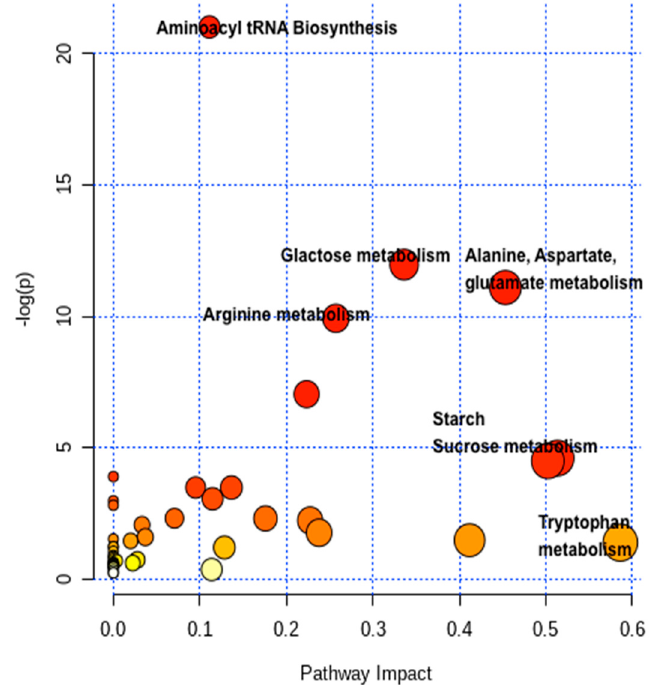
Figure 4. Metabolic pathway analysis plot created by using the MetaboAnalyst 2.0 software. Plots depict a change in several metabolic pathways due to the conditions of low-N, sufficient-N and restorations of N supply (3rd, 6th and 10th day) in maize genotypes. The x-axis represents the pathway impact values computed from the pathway topological analysis, and the y-axis is the -log of the p -value obtained from the pathway enrichment analysis. The color and size of each dot were associated with the -log ( p ) value and pathway impact value, respectively, where a small p value and high pathway impact value indicate that the pathway is greatly influenced.